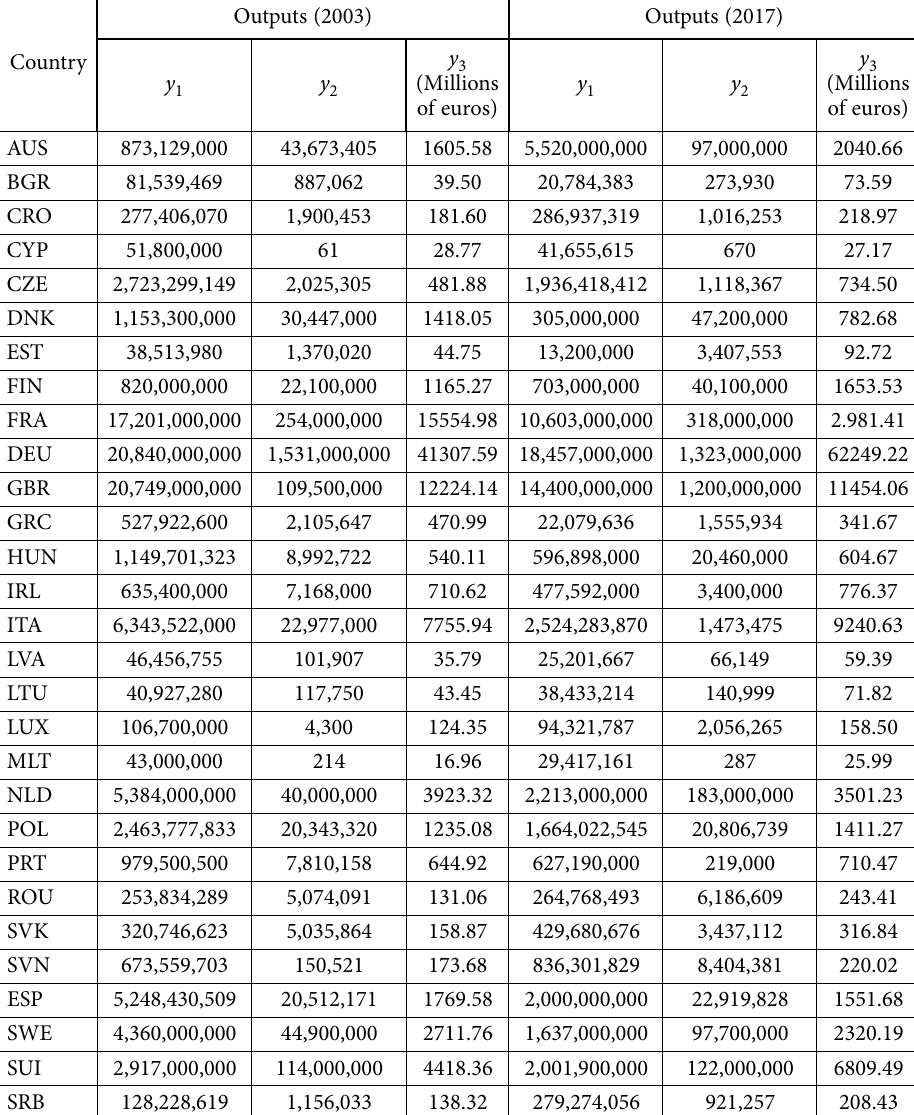
Table A3. Output variables data (source: Universal Postal Union 2019)